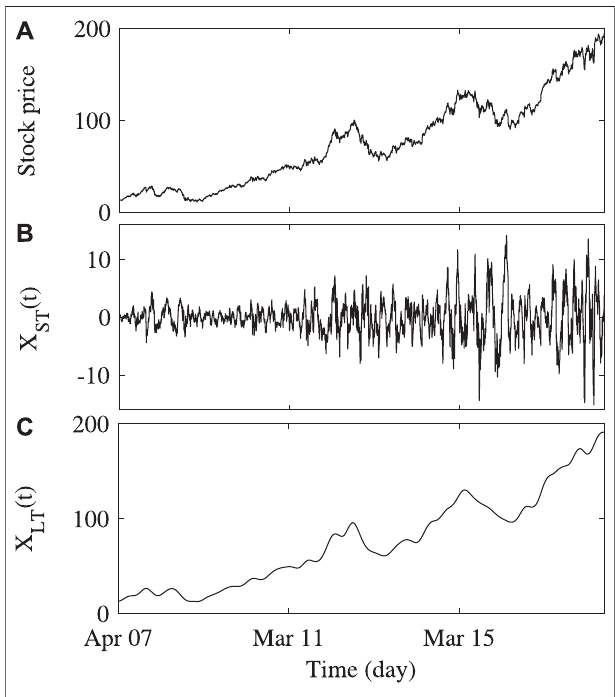
FIGURE 3 | (A) represents the daily price movement of Apple Inc. from April 2007 to March 2018. (B) , (C) represent the reconstructed short-term